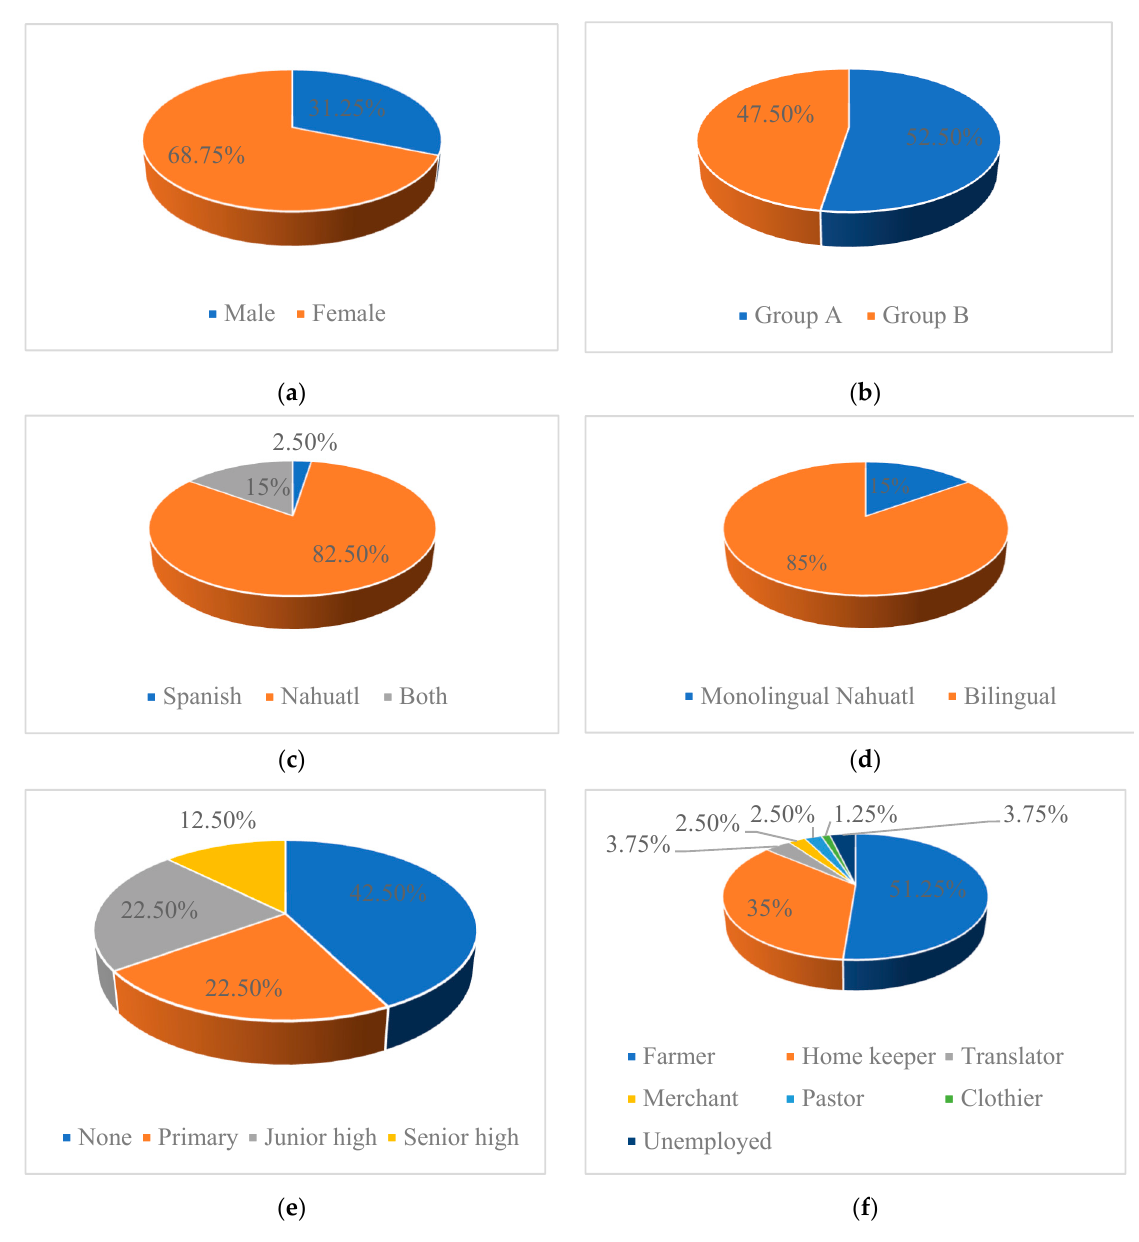
Figure 2. Characteristics of the adult population: ( a ) gender; ( b ) age groups; ( c ) first language(s); ( d ) type of speaker; ( e ) education; and ( f ) occupation.